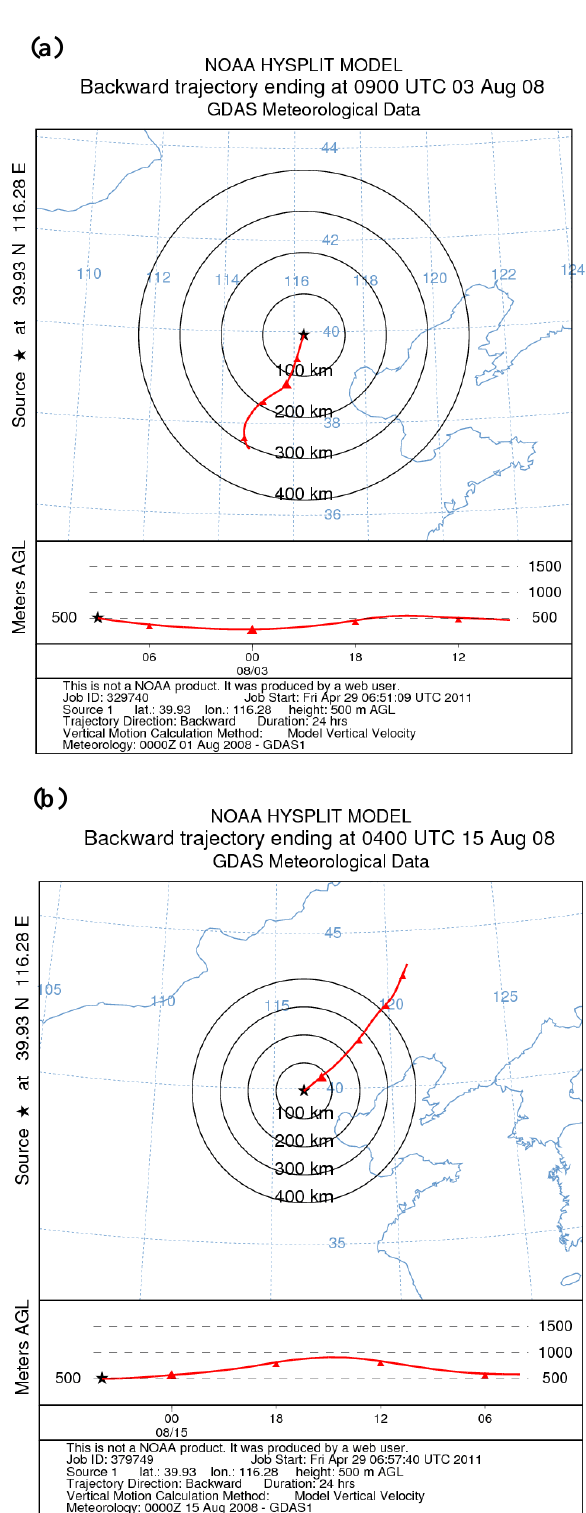
Fig. 6. Backward trajectories of air mass arriving Beijing at 17:00, 3 August (a) , and at 12:00, 15 August 2008 (b) . The trajectories were calculated for 24h from an altitude of 500m above the ground level of